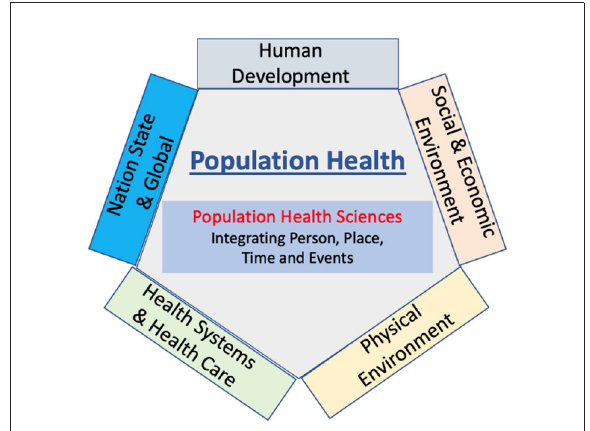
FIGURE1 Conceptual model of population